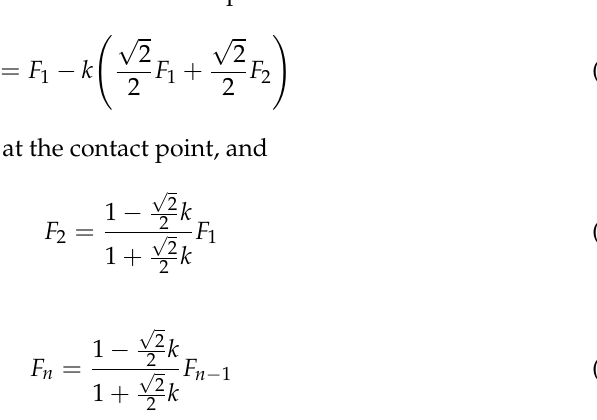
CFRWinding segment of CFR